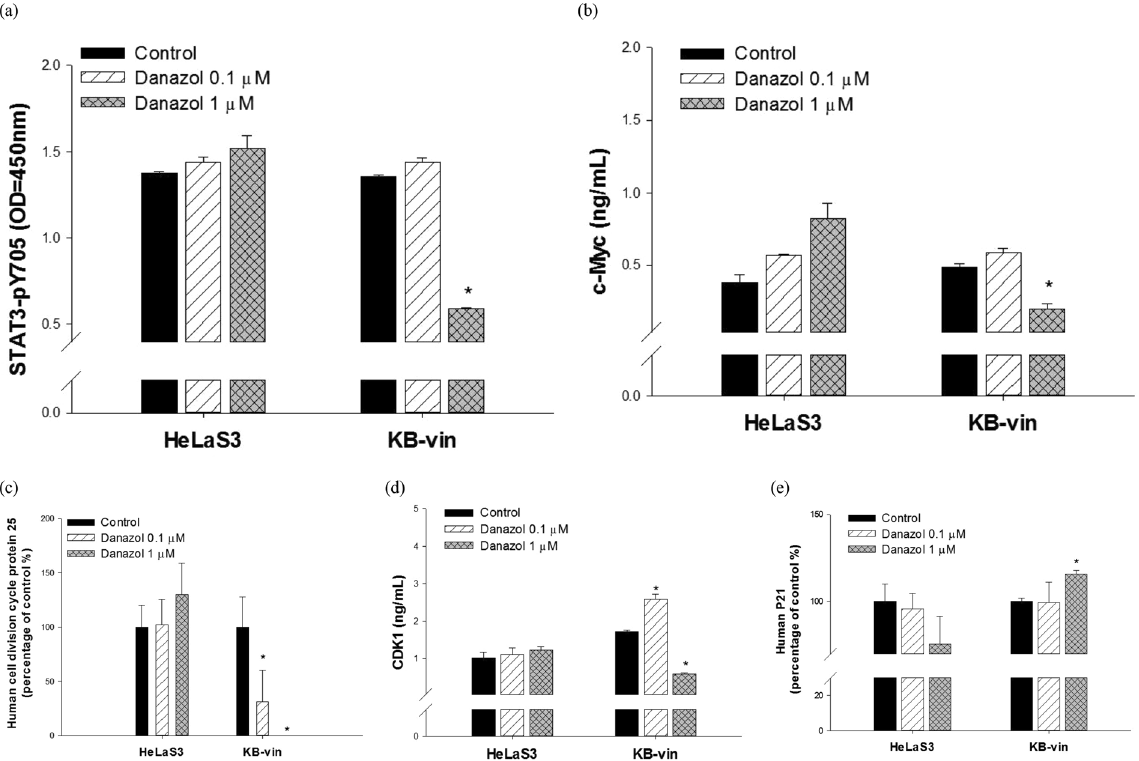
Figure 6. MYC signaling mediates danazol-induced G2/M arrest in MDR KB/VIN cells. HeLaS3 and KB/ VIN were treated with or without danazol for 72 hours. The whole-treated cells were extracted and analyzed by ELISA using antibodies specific to human ( a ) STAT3-pY705, ( b ) cMYC, ( c ) CDC25, ( d ) CDK1, and ( e ) p21. The results showed danazol reduced the concentration of MYC (c-Myc) and its upstream protein STAT3-pY705 in MDR KB/VIN cells. In addition, decreases in downstream signaling proteins, CDC25 and CDK1, were shown. Each experiment was performed in duplicate. Student’s t-test, * p < 0.05 compared with cells treated with medium only